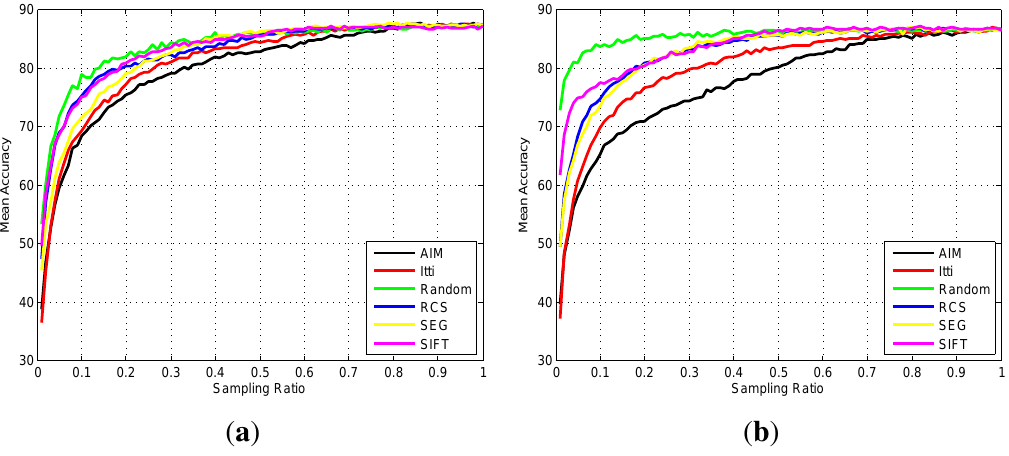
Figure 10. Comparisons of the overall classification accuracy using different sampling methods on the UC-Merced dataset ( a ) and the RS19 dataset ( b